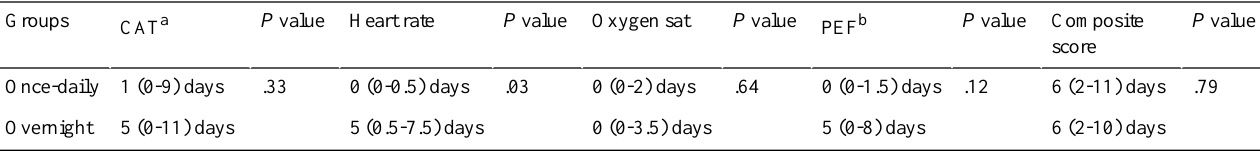
Table 4. Time difference to receive treatment between once-daily and overnight measurment